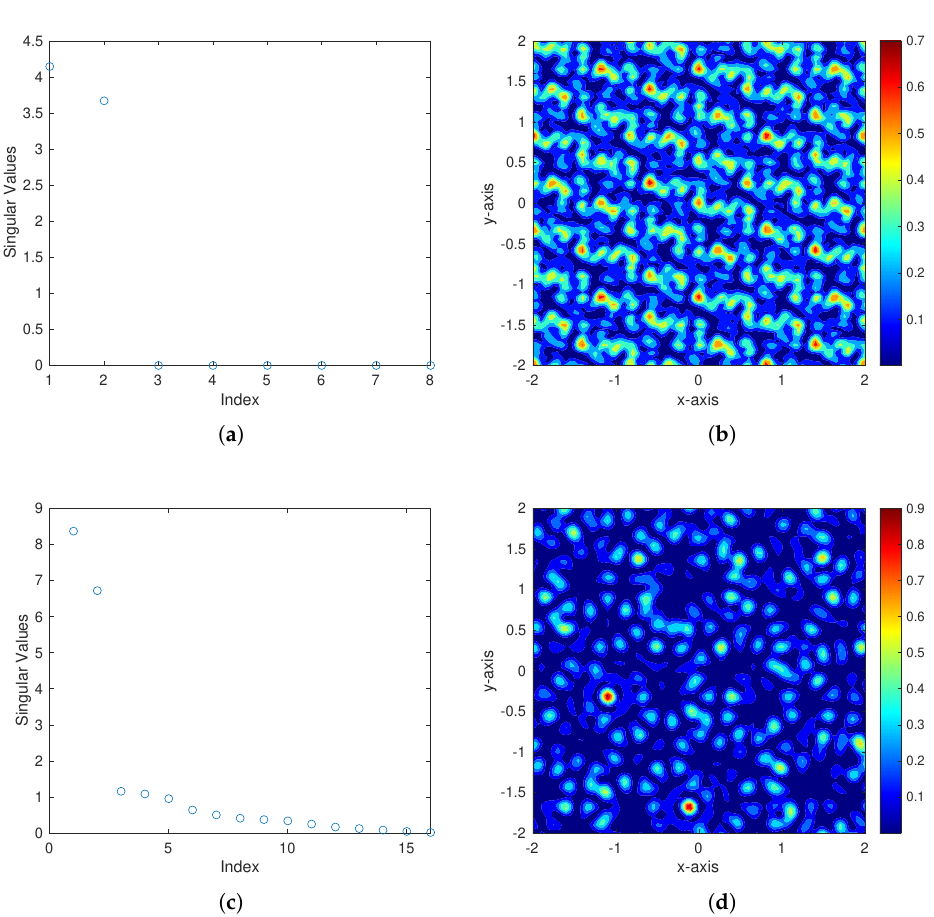
Figure 10. Singular value distribution and imaging result of limited-view data (top) and output data (bottom). ( a ) SVD with limited-view data; ( b ) imaging result with true data; ( c ) SVD with full-view data; ( d ) imaging result with learning data.